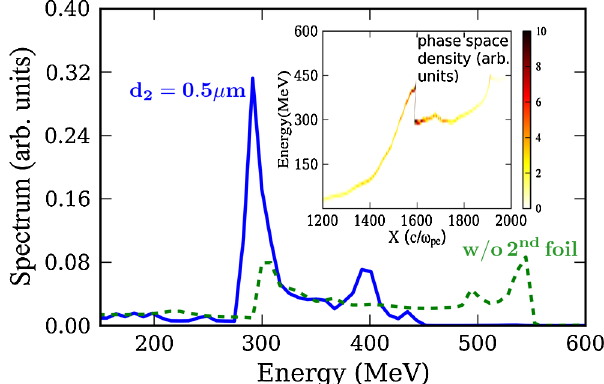
FIG. 4. Energy spectrum of the ion beam with (solid blue) and without (dashed, green) the second foil at t ¼ 158 fs . The spec- trum shows a quasimonoenergetic peak with (cid:1) E=E ¼ 6 : 4% at 290 MeV for the second foil thickness d 2 ¼ 0 : 5 (cid:4) m . The inset shows the phase space of the ion beam at t ¼ 158 fs .